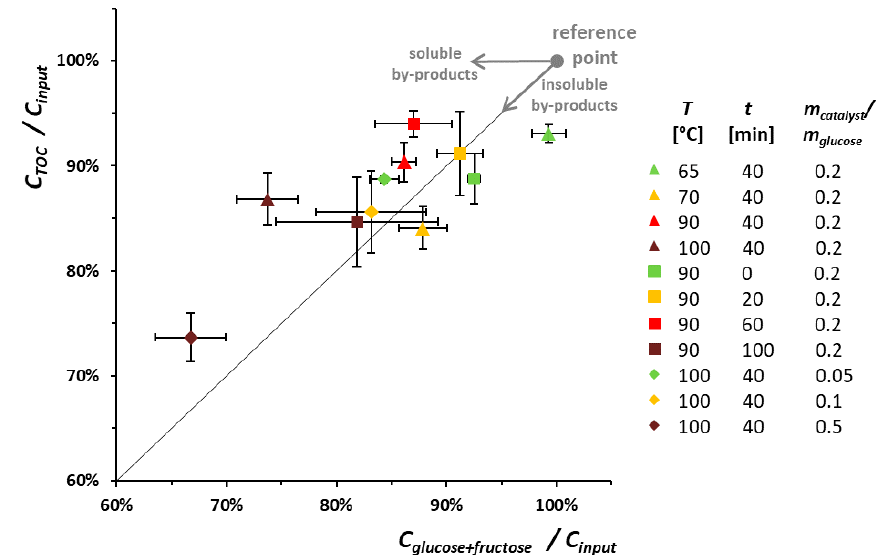
Figure 4. Carbon ratios for the isomerization of glucose with calcinated hydrotalcite; Y axis: TOC (total organic carbon) of the product liquid to carbon input of the glucose solution C TOC / C input ; X axis: carbon of glucose and fructose in the product liquid to carbon input of the glucose solution C glucose + fructose / C input ; reaction conditions: c glucose = 5 g / L, pH ≈ 7, air atmosphere.